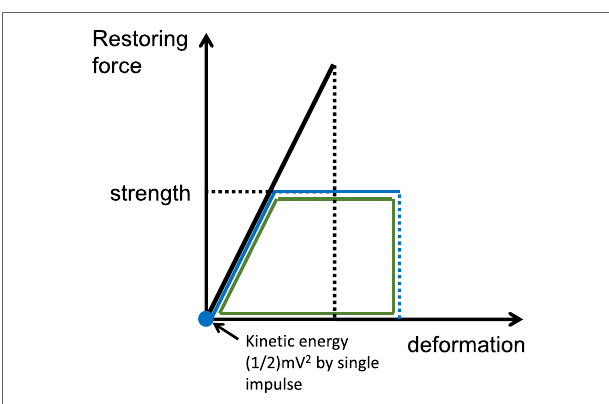
FIGURE 2 | Simple energy evaluation of elastic–plastic structure under impulsive loading